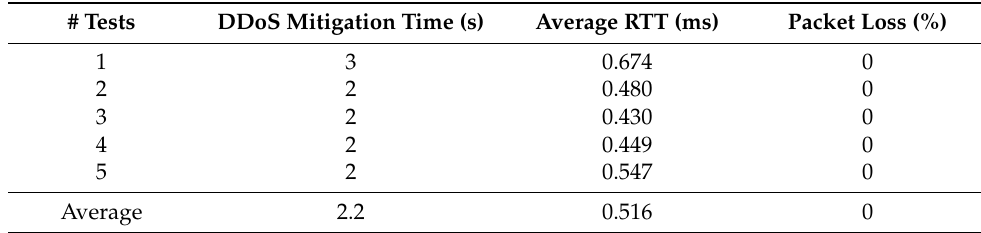
Table 6. Scenario III—Performance